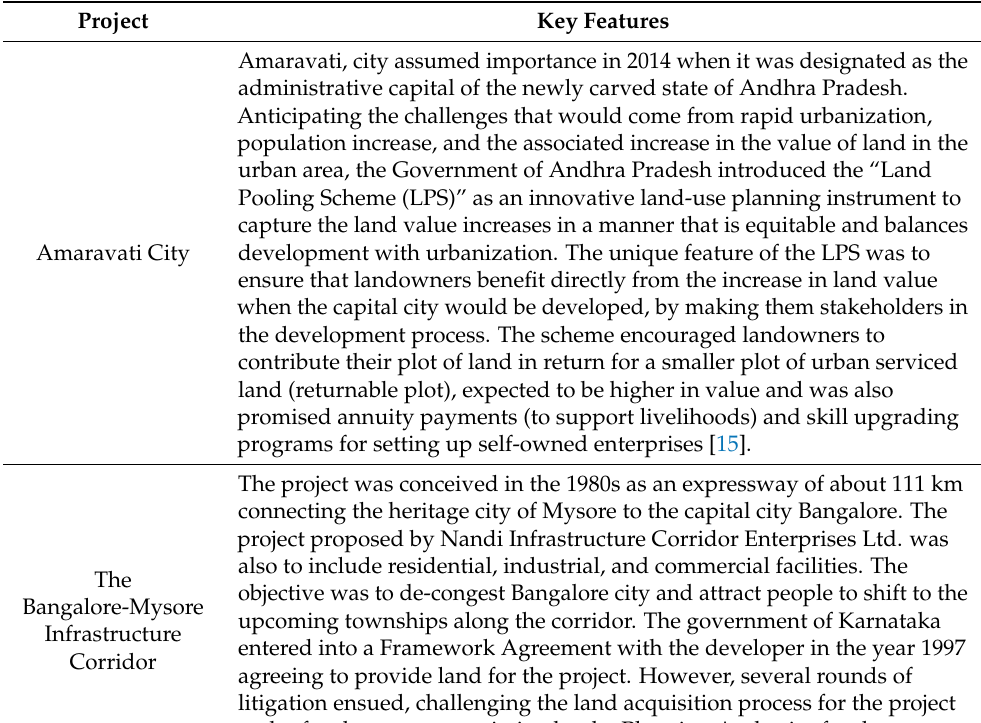
Table 2. Illustrative projects that incorporated land-based financing